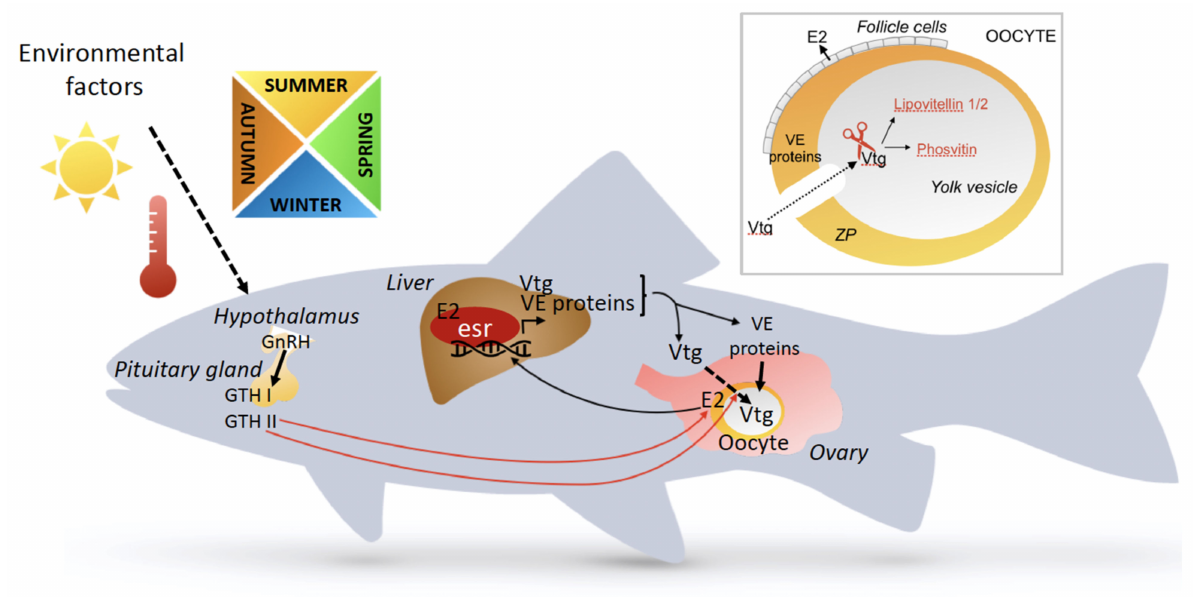
Figure 1. Crosstalk between liver and ovary in the production of egg yolk and eggshell proteins. Fish is taken as example in this figure. Various environmental factors stimulate the hypothalamus to secrete GnRH. In response to GnRH, the pituitary gland secretes GTHs, which stimulate both the production of 17 β -estradiol (E2) in follicle cells and vitellogenin uptake in the oocytes. Vitellogenins are proteins representing the principal source of nutrients in the egg yolk of oviparous vertebrates. They are produced in the liver under the strict control of E2, secreted into the bloodstream and are taken up under the control of GTH by the growing oocytes in the ovary and cleaved into lipovitellins and phosvitins. E2: 17 β -estradiol; esr: estrogen receptor; Vtg: vitellogenin; VE: vitellin envelope; GTH: gonadotropin; GnRH: gonadotropin releasing hormone.